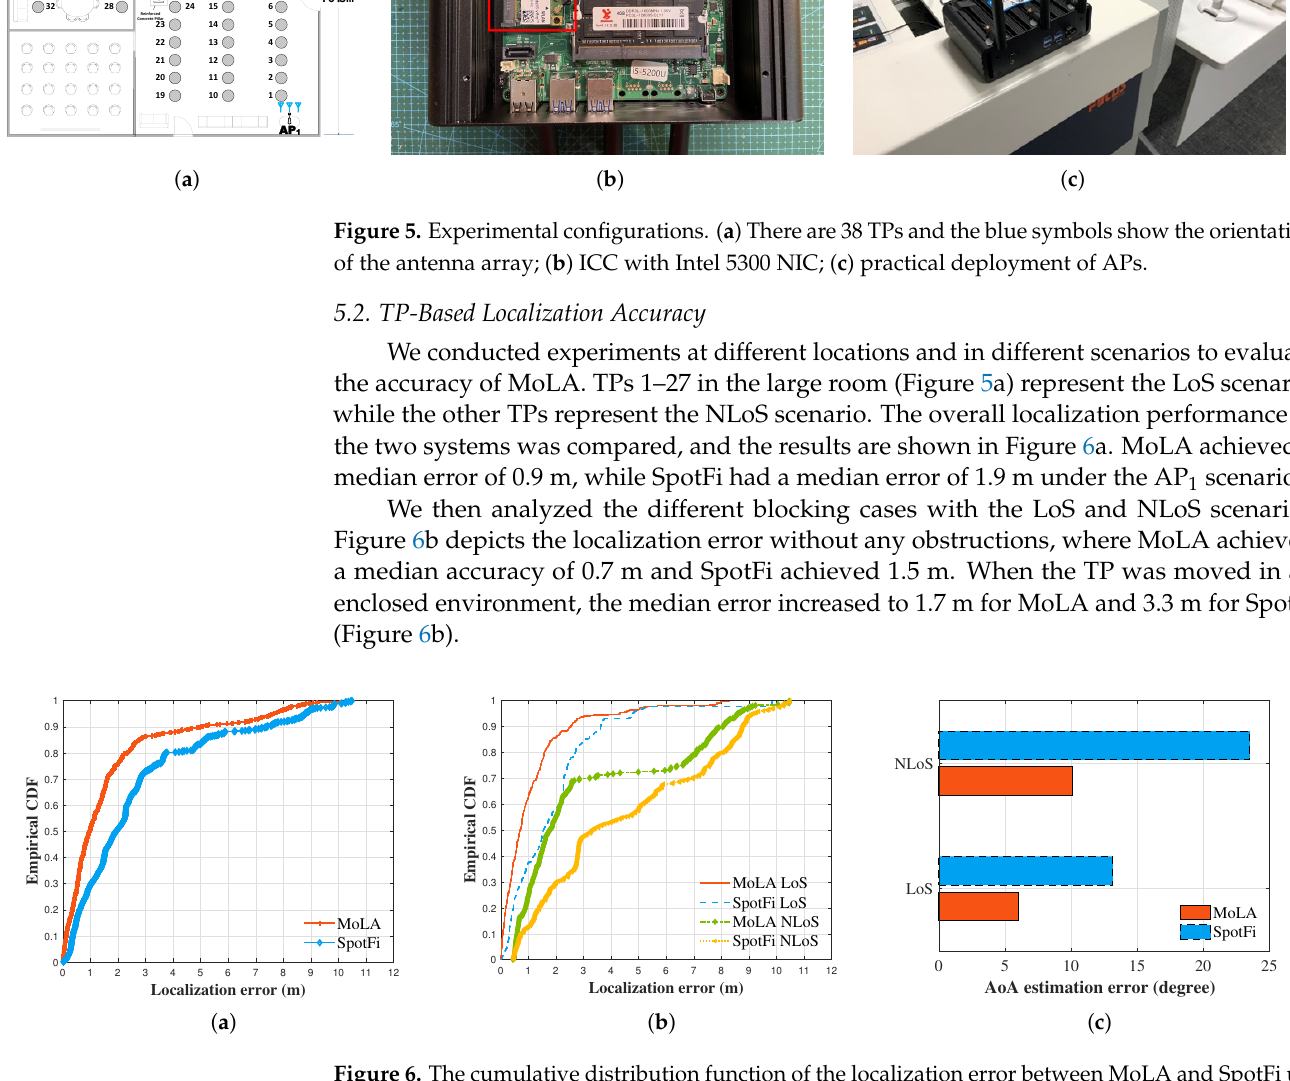
Figure 6. The cumulative distribution function of the localization error between MoLA and SpotFi un- der the LoS and NLoS scenarios. ( a ) Overall localization error; ( b ) the LoS/NLoS case; ( c ) comparison of the AoA estimation error in